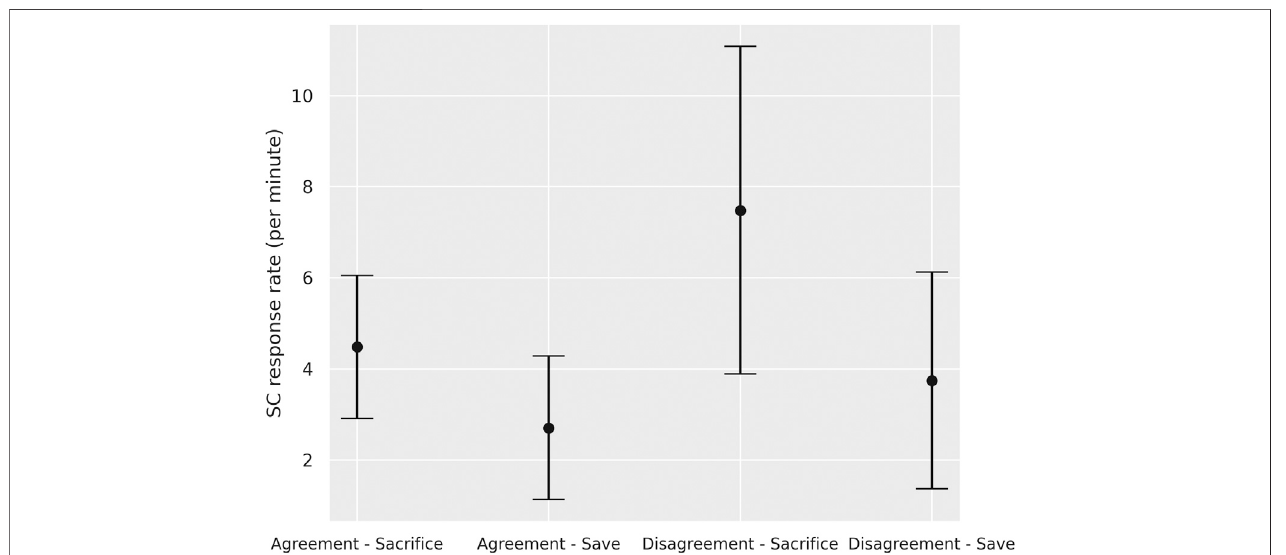
Frontiers in Communication |